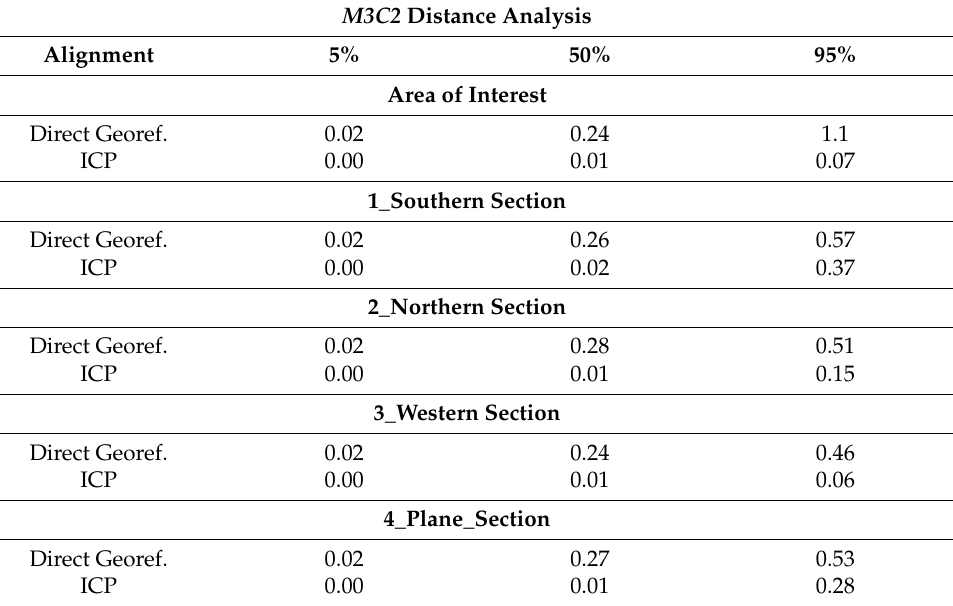
Table 8. M3C2 distance analysis between TLS and ALS for the building area. Mean distance for 5%, 50%, and 95% of the points.